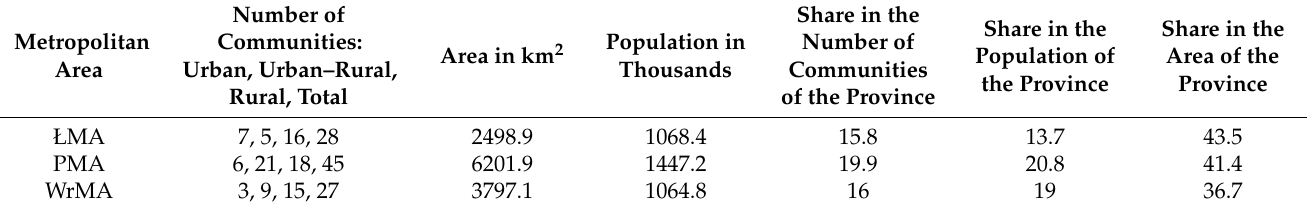
Table 1. Basic information about analyzed metropolitan areas